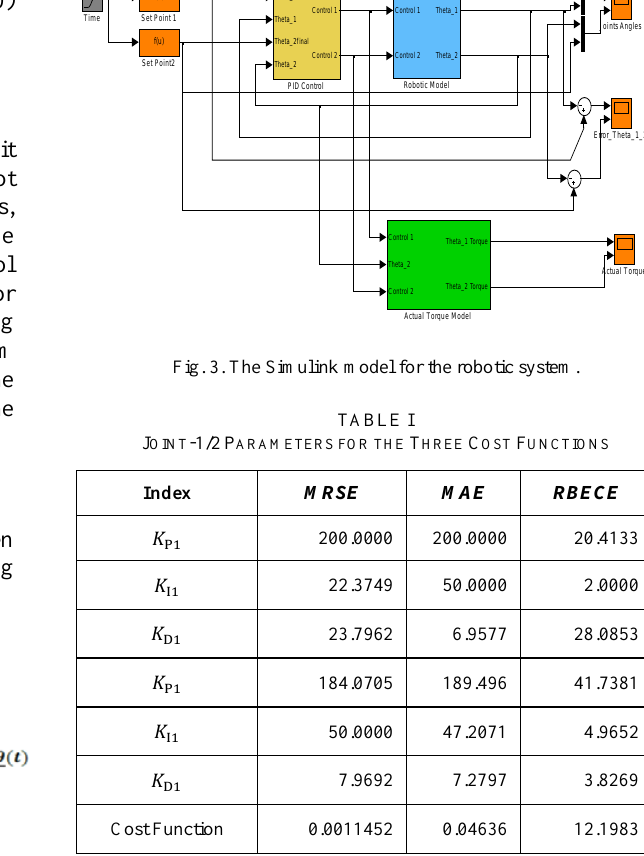
Fig. 2. Robotic system PID tuning schematic diagram.